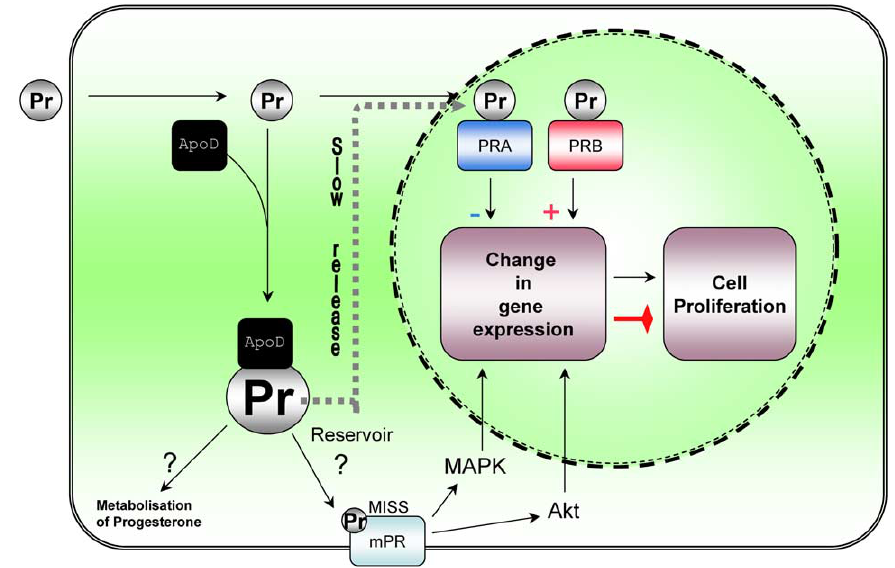
Fig. 6. Two models showing how ApoD may interact with progesterone. 1. In the cytoplasm ApoD may bind progesterone and divert it to metabolic degradation. This will reduce the effect of progesterone in both the genomic and MISS pathway. 2. ApoD binds free progesterone and hides it away from metabolisation. This will create an intracellular reservoir of progesterone and a “slow release” effect ( ) on the genomic pathway may occur. Also, this may enhance ( ) the MISS progesterone pathway. See text for further discussion. Abbreviations: ApoD: Apolipoprotein D; MAPK: mitogen activated protein kinase; mPR: membrane progesterone receptor; Pr: progesterone; PRA: progesterone receptor A; PRB: progesterone receptor